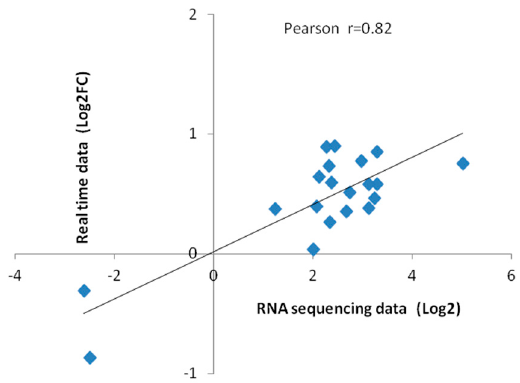
Figure 8. Correlation between sequencing data and quantitative RT-PCR data. Each point represents a value of expression level. Both the X and Y-axes are shown in log 2 scale. And r indicates the correlation coefficient.